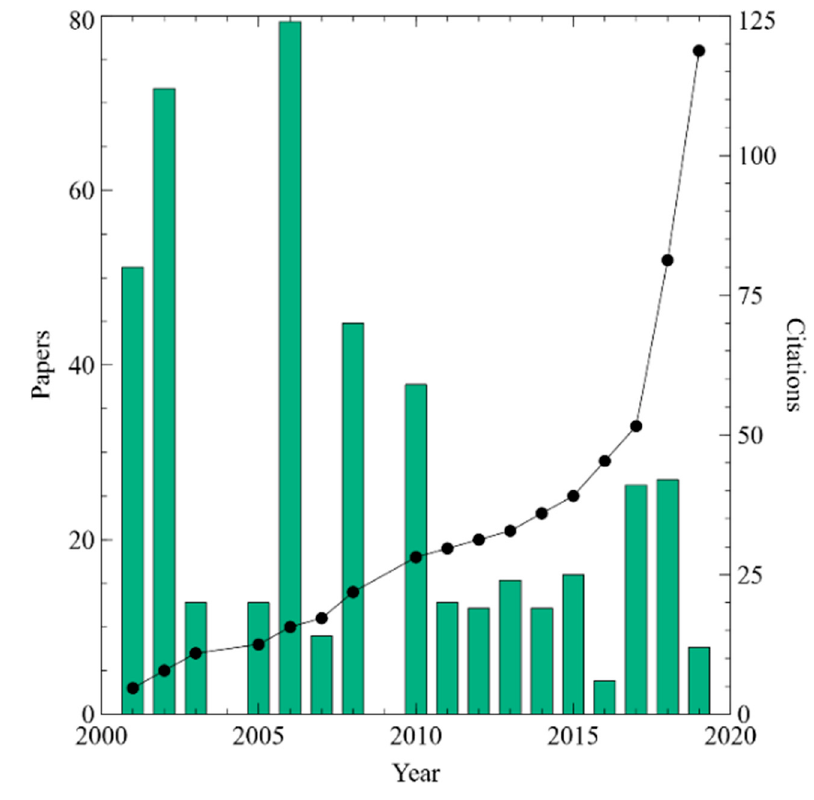
Figure 1. Cumulative production of papers and citations per year.